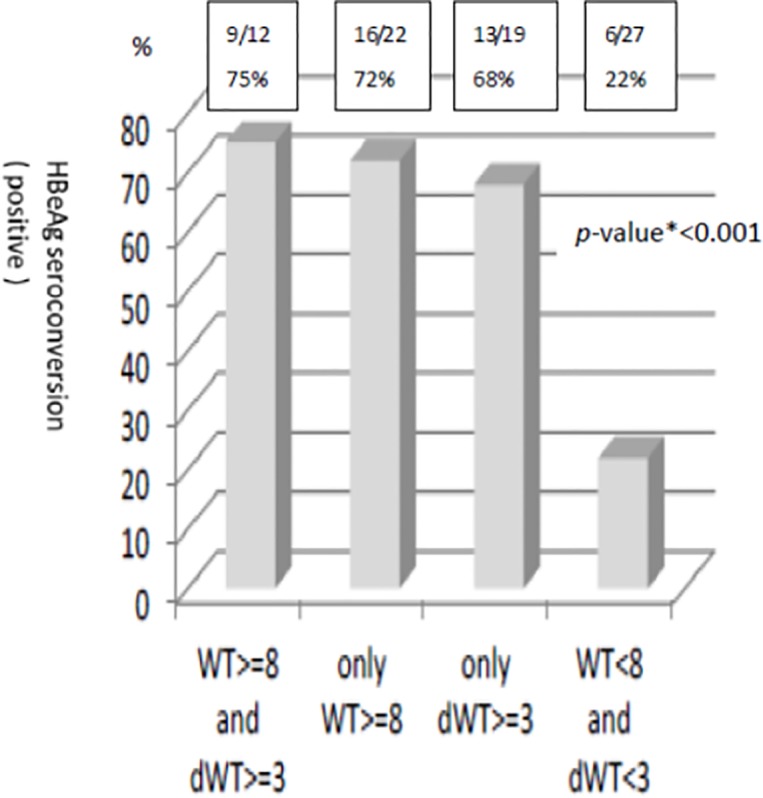
The power of combining nodal width (WT) at acute flare stage and nodal change (dWT) between acute flare and recovery stage to predict HBeAg seroconversion.*p-value is from Pearson’s chi-square test.